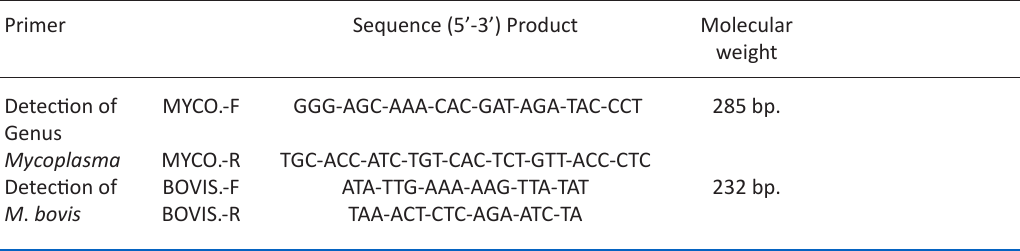
Table 1. Primers used to detect Mycoplasma genus and M. bovis strains Primer Sequence (5’-3’)